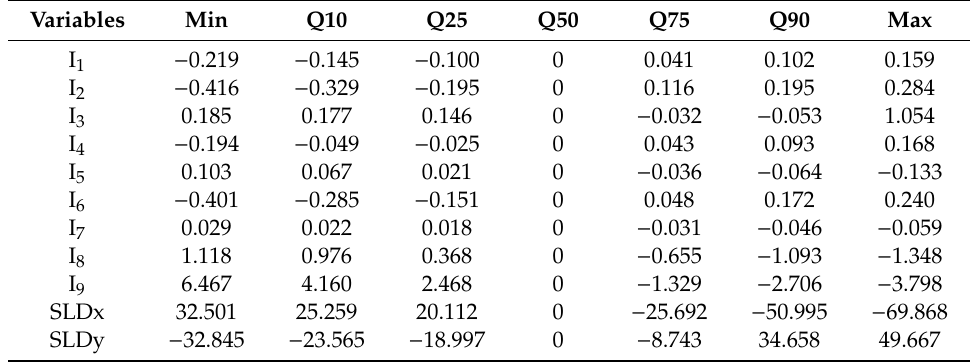
Figure 9. Degree of sensitivity (in %) of SLDx and SLDy on the prediction of critical buckling load through the ANFIS-BBO model. Table 6. Summary of the degree of sensitivity (in %) of input variables at different intensity values.